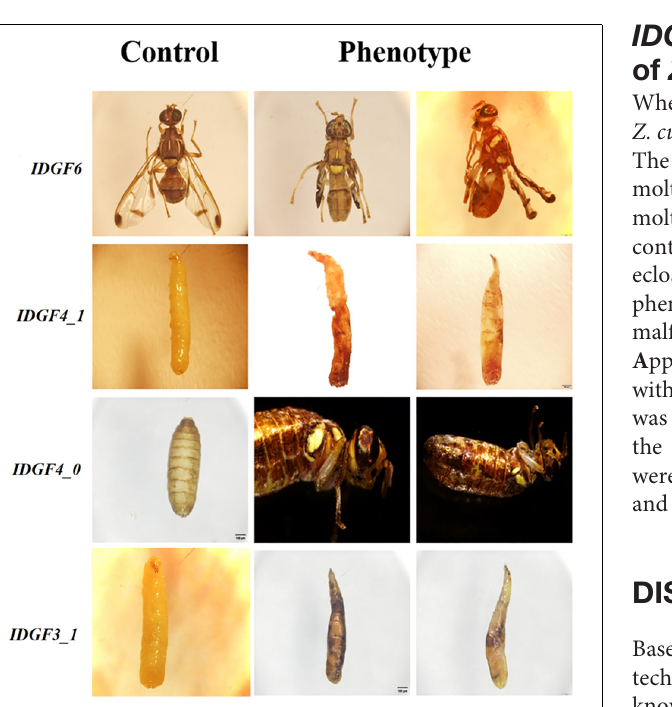
5–6 days of pupation, a mortality of 49.2% was recorded ( Figure 7 ). Furthermore, Z. cucurbitae failed to shed their old cuticle, and the mature cuticle was visible under the old cuticle resulting in the splitting of the old pronotal cuticle ( Figure 6 ). In comparison, no abnormalities were recorded in control groups, either dsRNA-GFP or